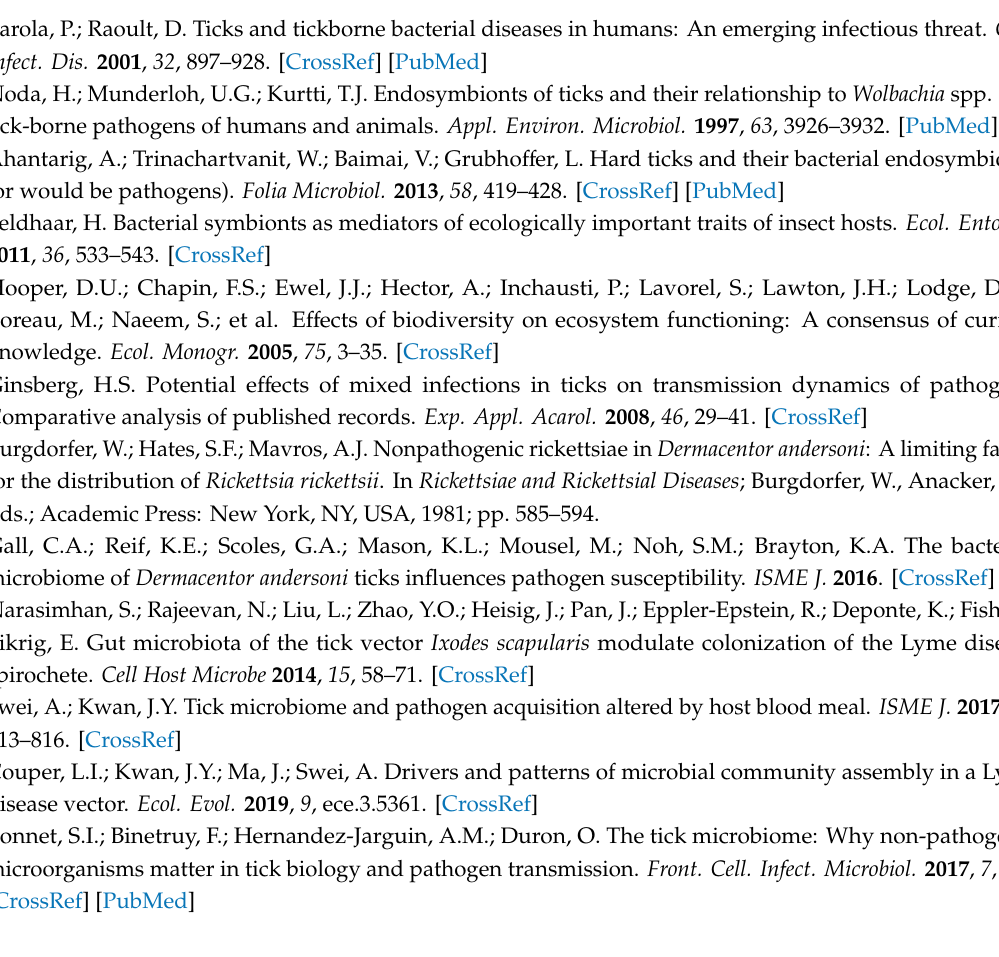
Figure S1: Microbiome representation of nymphs by species, Figure S2: Microbiome representation of adults by species, Figure S3: Relative abundance of core microbiota by tick species, Figure S4: Relative abundance of rare genera (See Methods: Sequence processing) by tick species, Figure S5: Microbiome composition by tick species and adult sex, Figure S6: Microbiome representation of larval D. albipictus , D. occidentalis , and I. pacificus by region (China Camp State Park in Marin, CA or Jack London State Park in Sonoma, CA., Table S1: Sample Size for Treatment Groups, Table S2: Species Richness by Species & Life Stage, Table S3: Species Diversity by Species & Life Stage, Table S4: Top sequence BLAST results from OTUs identified as core microbiota, Table S5: Variation in functional gene content by sample type, Table S6: OTU Richness by Location, Table S7: OTU Diversity by